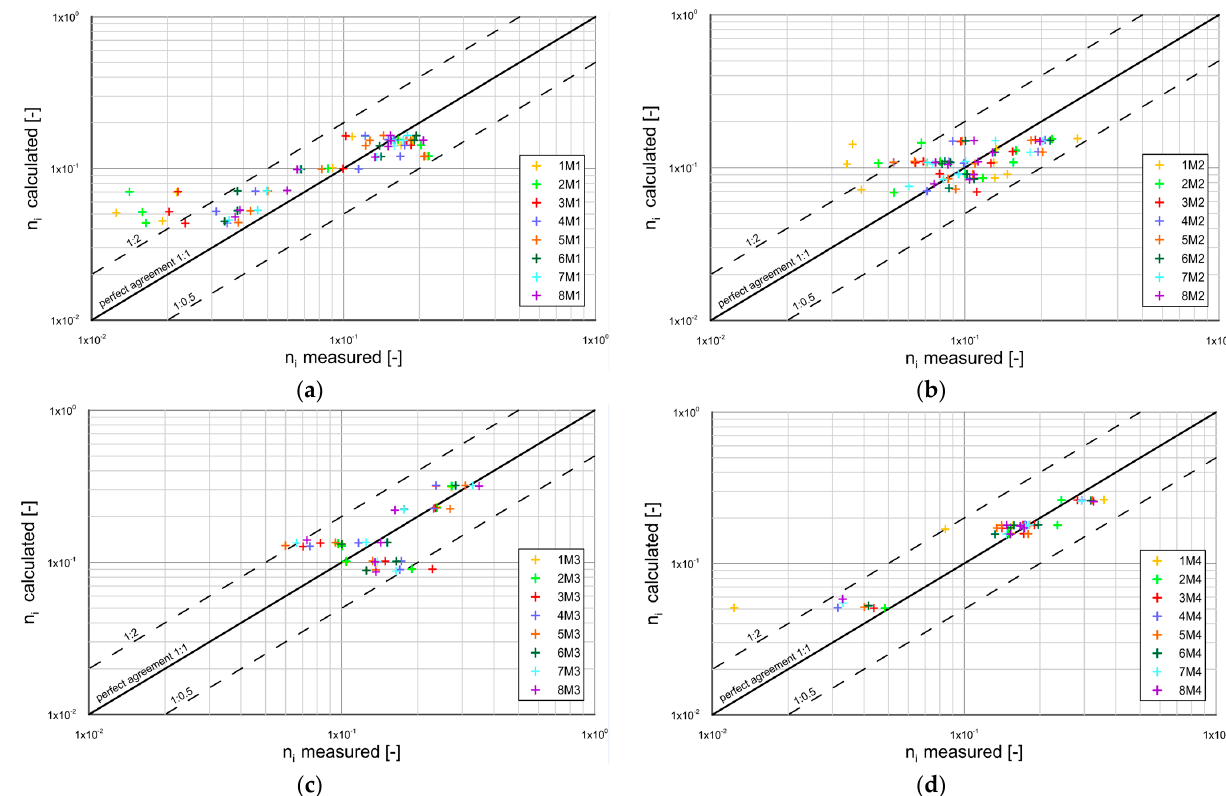
Figure 17. Comparison of grain size distribution calculations with measurements by [53] for: initial grain size distribution: ( a ) M1, ( b ) M2, ( c ) M3 and ( d )